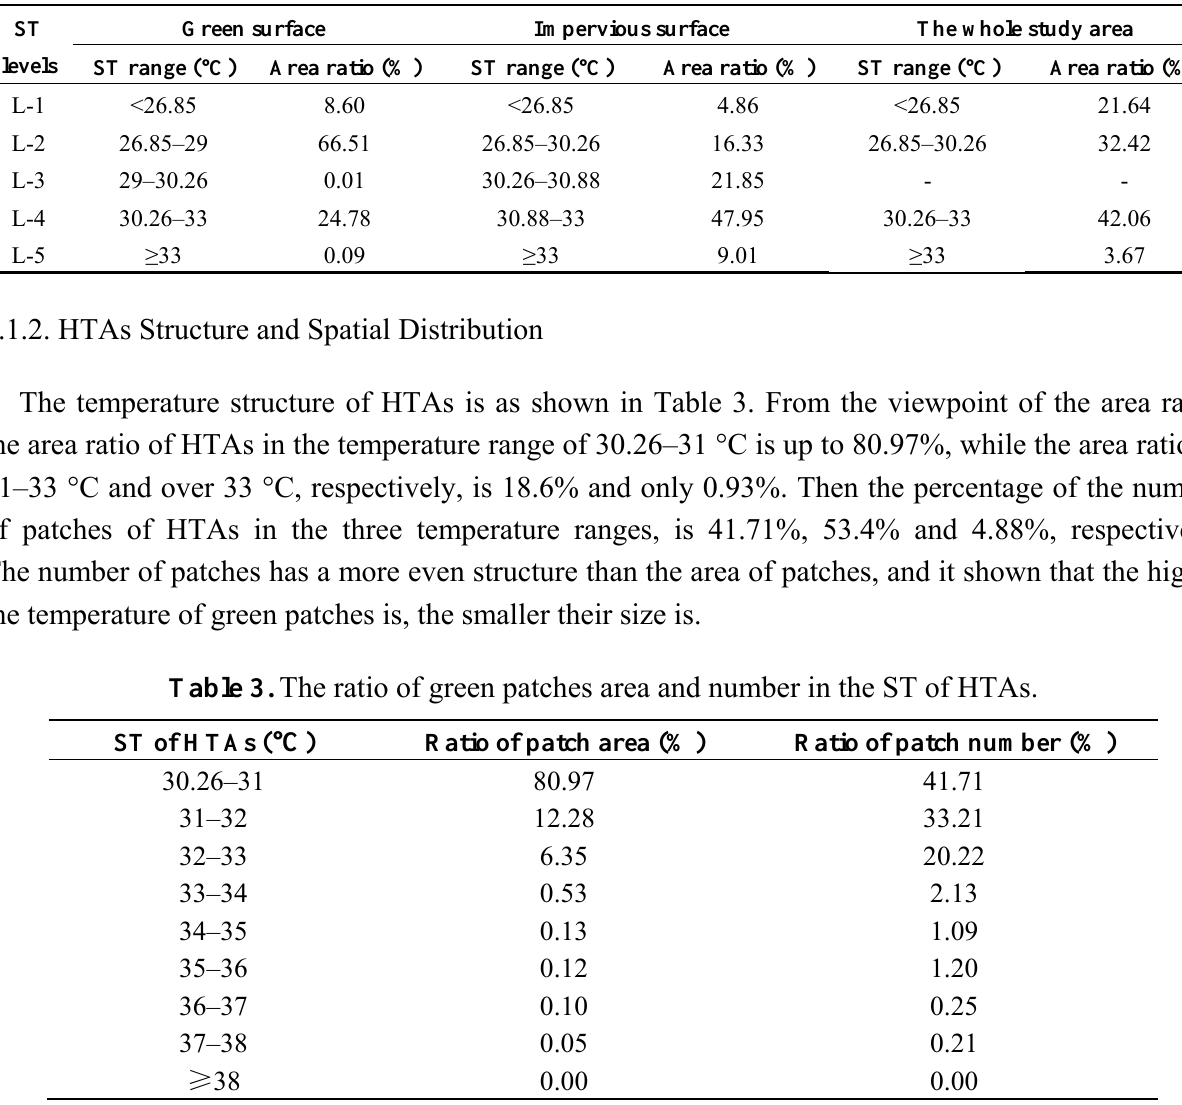
Table 2. The range of the ST levels and their ratio in surface types.